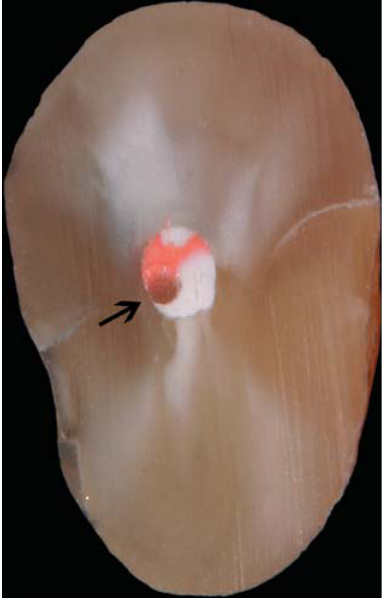
Figure 1- (cid:2)(cid:26)(cid:5)(cid:11)(cid:17)(cid:10)(cid:20)(cid:2) (cid:17)(cid:6)(cid:14)(cid:7)(cid:7)(cid:2) (cid:7)(cid:4)(cid:17)(cid:9)(cid:11)(cid:14)(cid:8)(cid:2) (cid:14)(cid:19)(cid:2) (cid:9)(cid:16)(cid:4)(cid:2) (cid:6)(cid:14)(cid:14)(cid:9)(cid:2) (cid:17)(cid:10)(cid:8)(cid:10)(cid:20)(cid:2) (cid:21)(cid:20)(cid:20)(cid:11)(cid:8)(cid:15)(cid:2) showing the nylon thread used to simulate the void